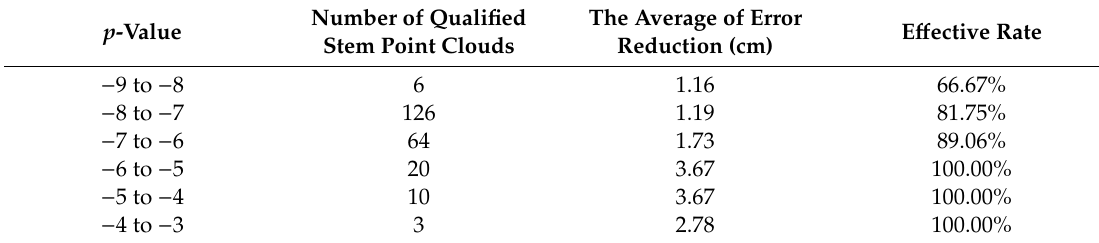
Table 5. The e ff ective rates of ANPDA.